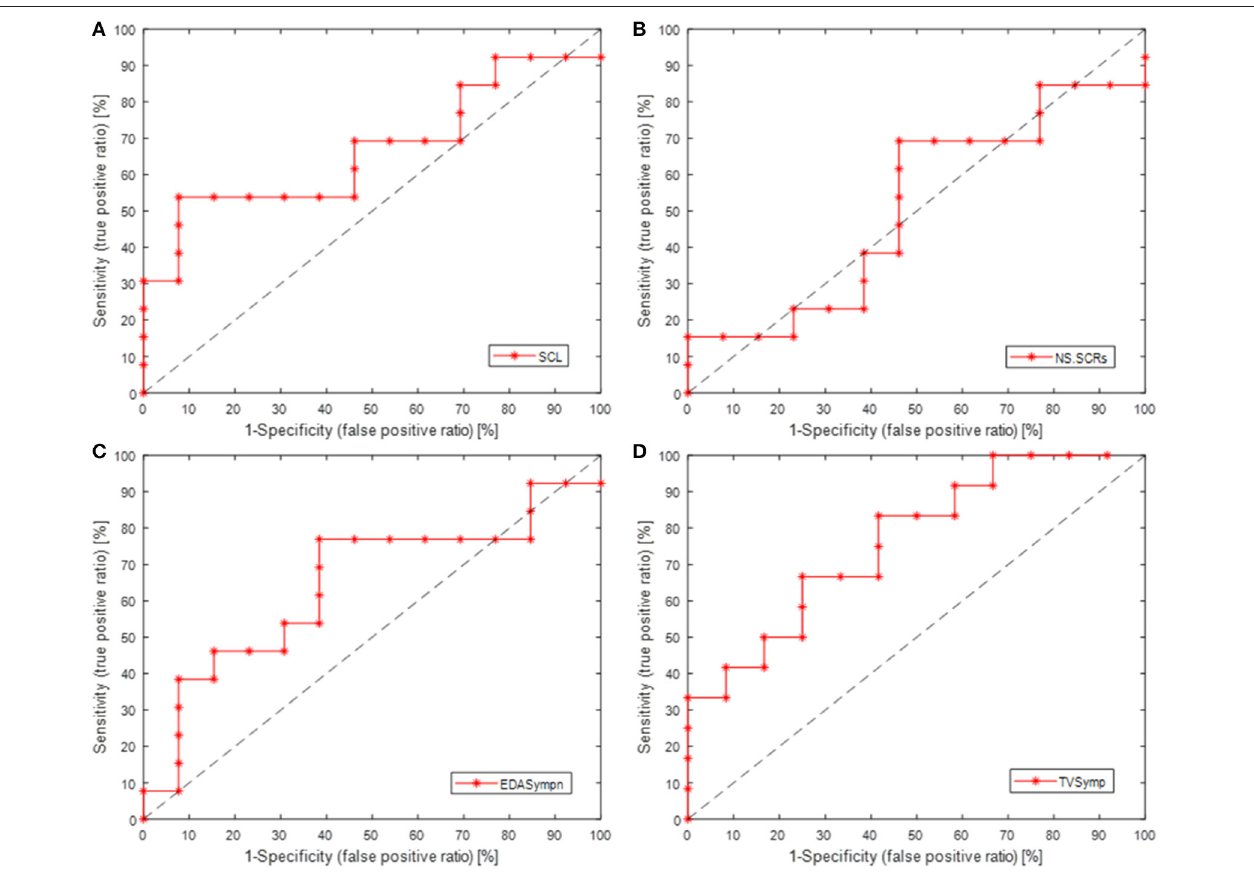
FIGURE 4 | ROC curves (sensitivity vs. 1-specificity) for the measures of EDA, as detectors of cognitive stress induced by Stroop task underwater. (A) SCL, skin conductance level; (B) NS.SCRs, non-specific skin conductance responses; (C) EDASympn, normalized power spectra in the 0.045 to 0.25Hz band; (D) TVSymp, time-varying index of